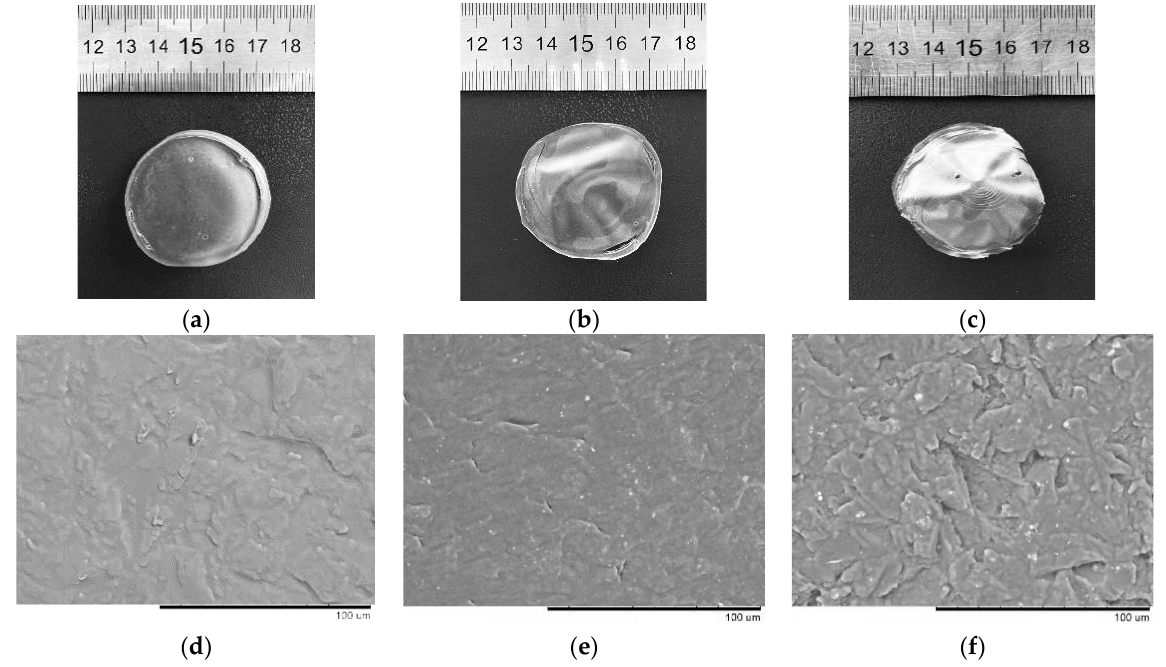
Figure 2. The photo ( a ) and SEM image ( d ) showing the native starch film; the photo ( b ) and SEM image ( e ) of the amorphous starch film; and the photo ( c ) and SEM image ( f ) of nano starch-based film.